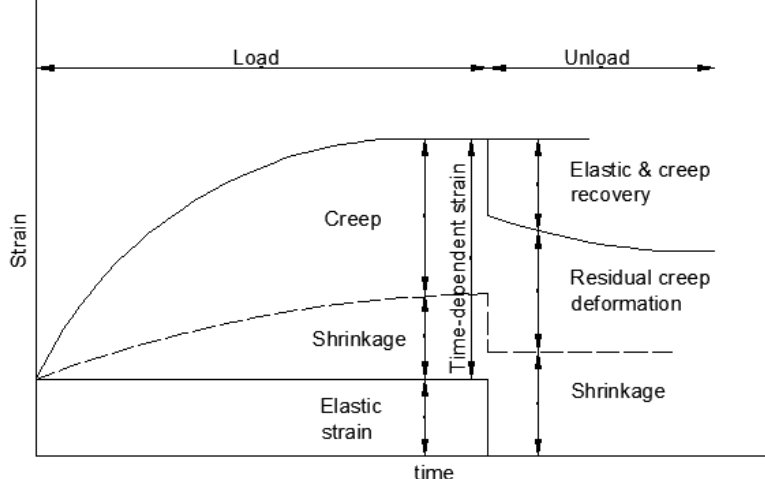
Figure 6. Creep strain after loading.